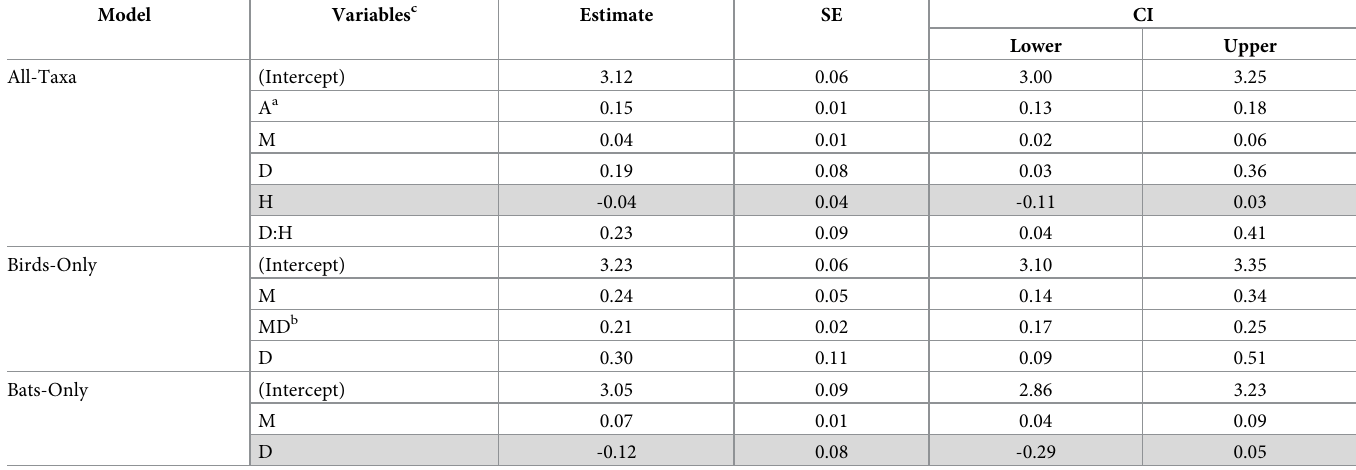
Table 9. Model-averaging results for all-taxa, birds-only, and bats-only top model sets. Included are standardized coefficient estimates (Estimate), unconditional stan- dard errors (SE), and 95% confidence intervals (CI) for each model set. Shaded rows represent variables with confidence intervals crossing zero. Model